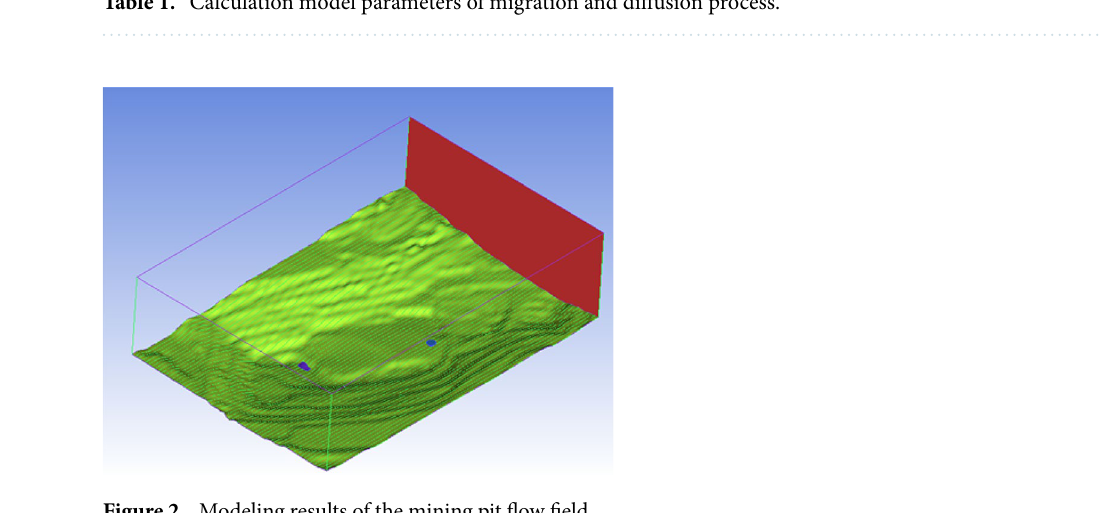
Table 1. Calculation model parameters of migration and diffusion process.